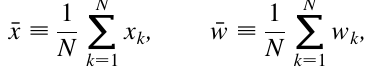
FIG. 2. Example of a quadrupole mode at three different times t diagrams show the corresponding beam current I and I (dashed amplitudes I 0 1